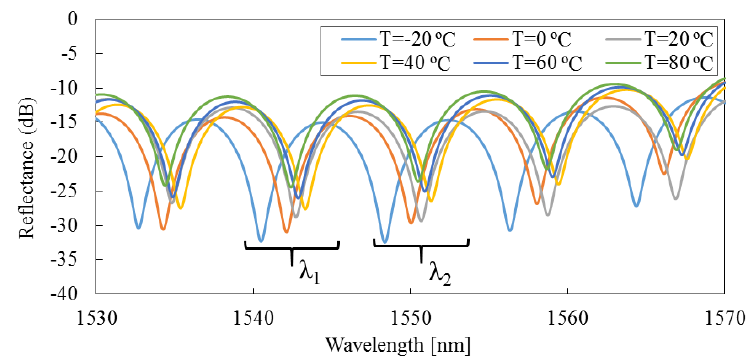
Figure 10. Interference spectra of the fabricated FFPI sensor in RIMM with temperature increase from −20 to 80 °C.